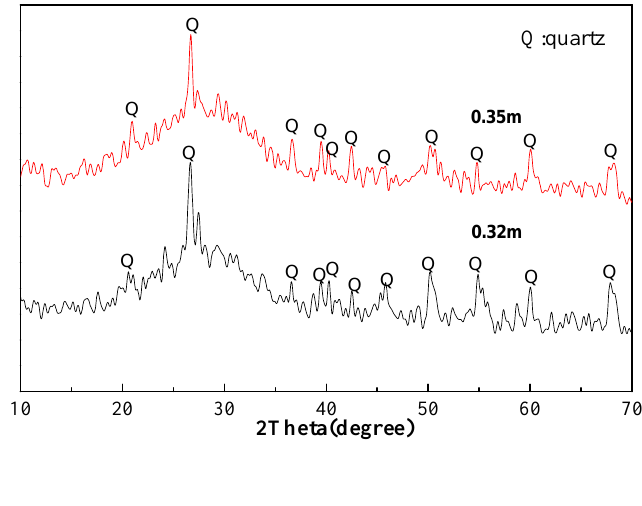
Figure 4. X-ray diffraction of the mortar with 0.32 and 0.35 of water-to-fly ash